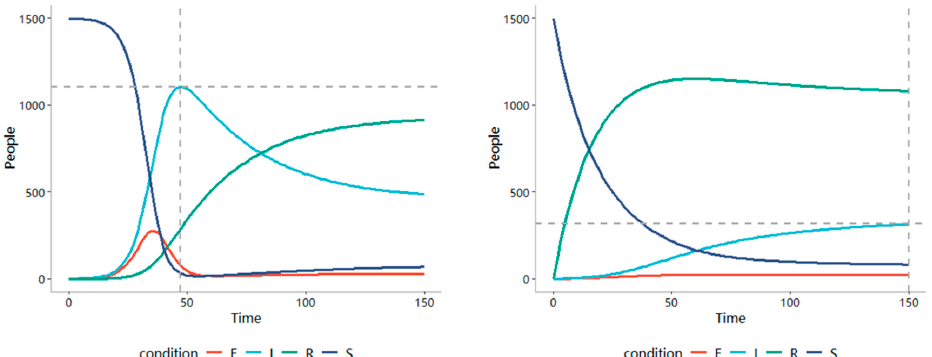
Figure 11. Impact of vaccination rate µ (probably of directly changing from S to R ) on the dissemination of CLPP. Farmers’ evaluation of the benefits of implementing CLPP is the result of a combina- tion of multiple factors. It is affected not only by information and public opinion, but also